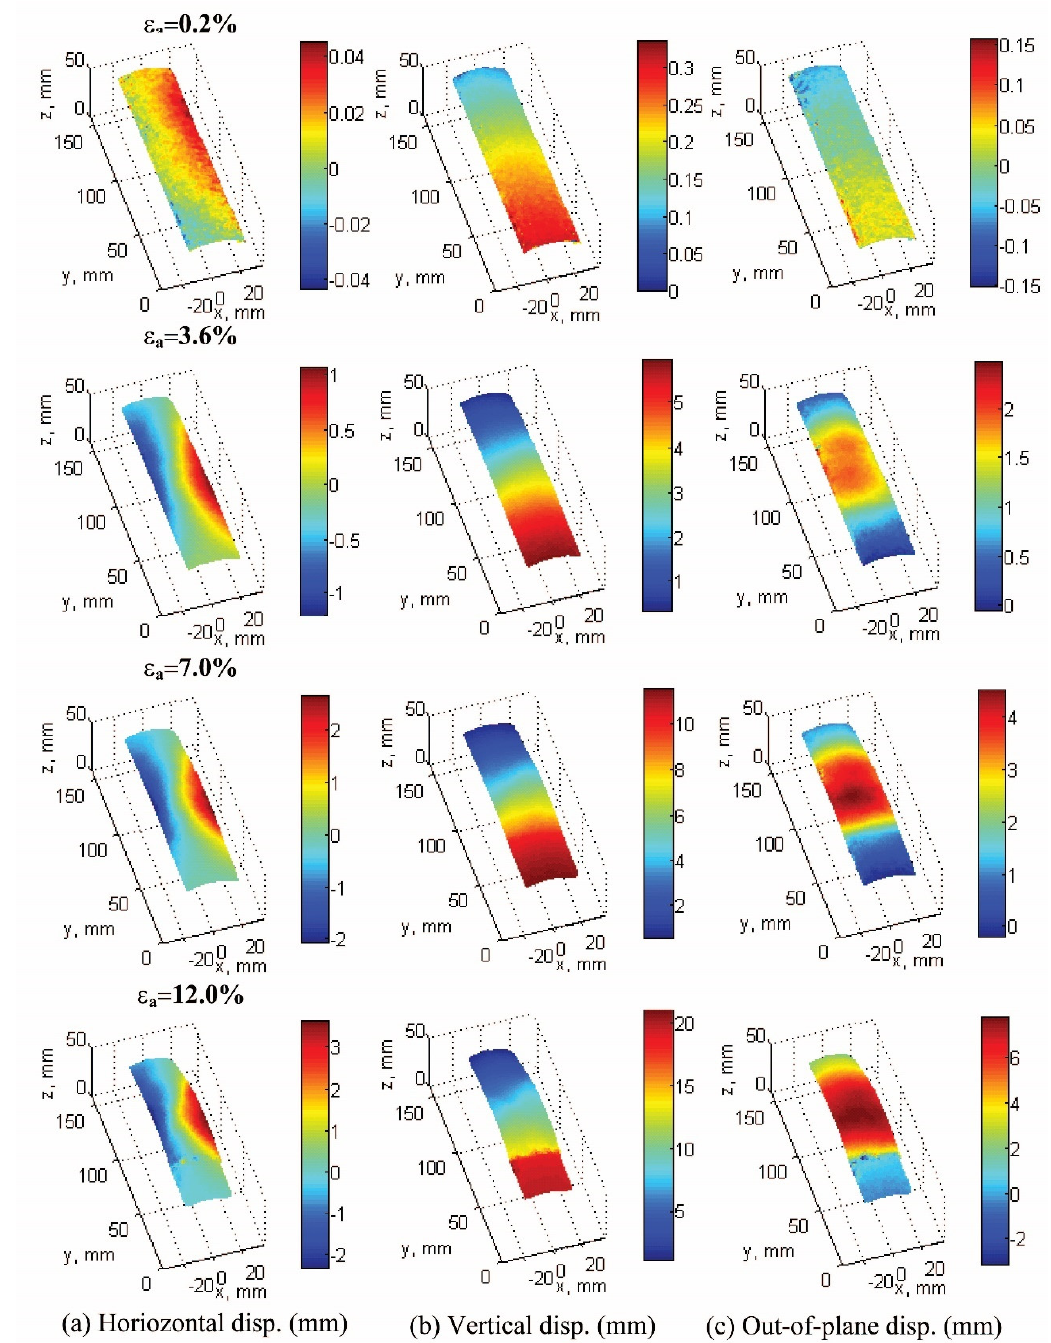
Figure 16 . Cumulative displacement fields of test 120904c using Cartesian coordinates at 0.2%, 3.6%, 7%, and 12% of axial strain: horizontal displacement field u ( a ), vertical displacement field v ( b ), and out ‐ of ‐ plane displacement field w ( c ).